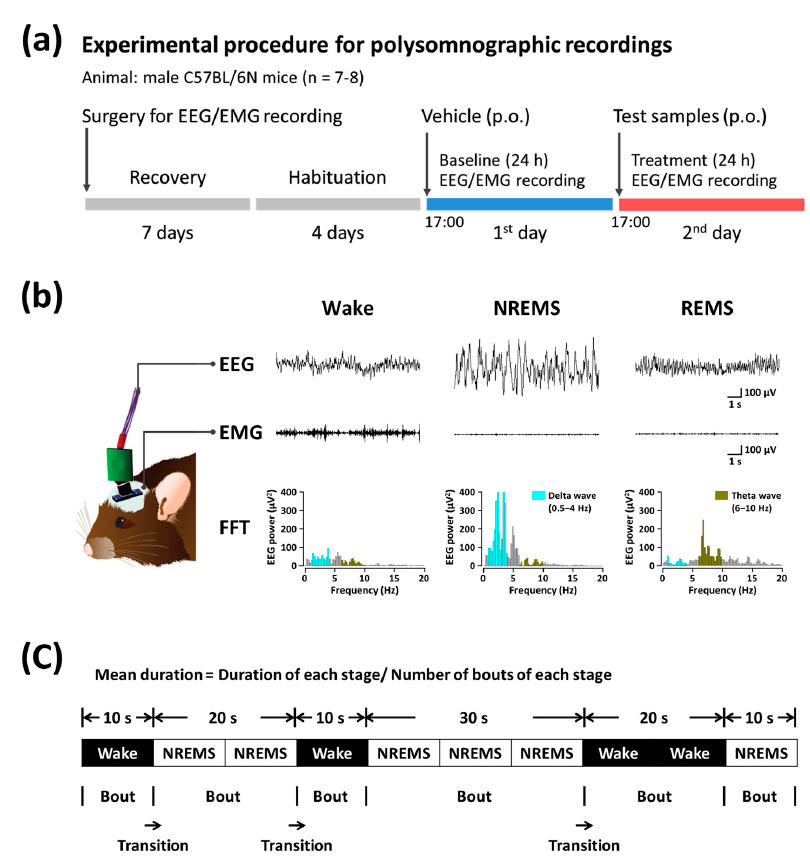
Figure 1. Experimental procedures and timelines for the polysomnographic recordings ( a ) and typical EEG and EMG waveforms, and FFT spectrum in mice ( b ); ( c ) Definition of sleep-wake episodes. EEG, electroencephalogram; EMG, electromyogram; FFT, fast Fourier transform; REMS, rapid eye movement sleep; NREMS, non-REMS; Wake,